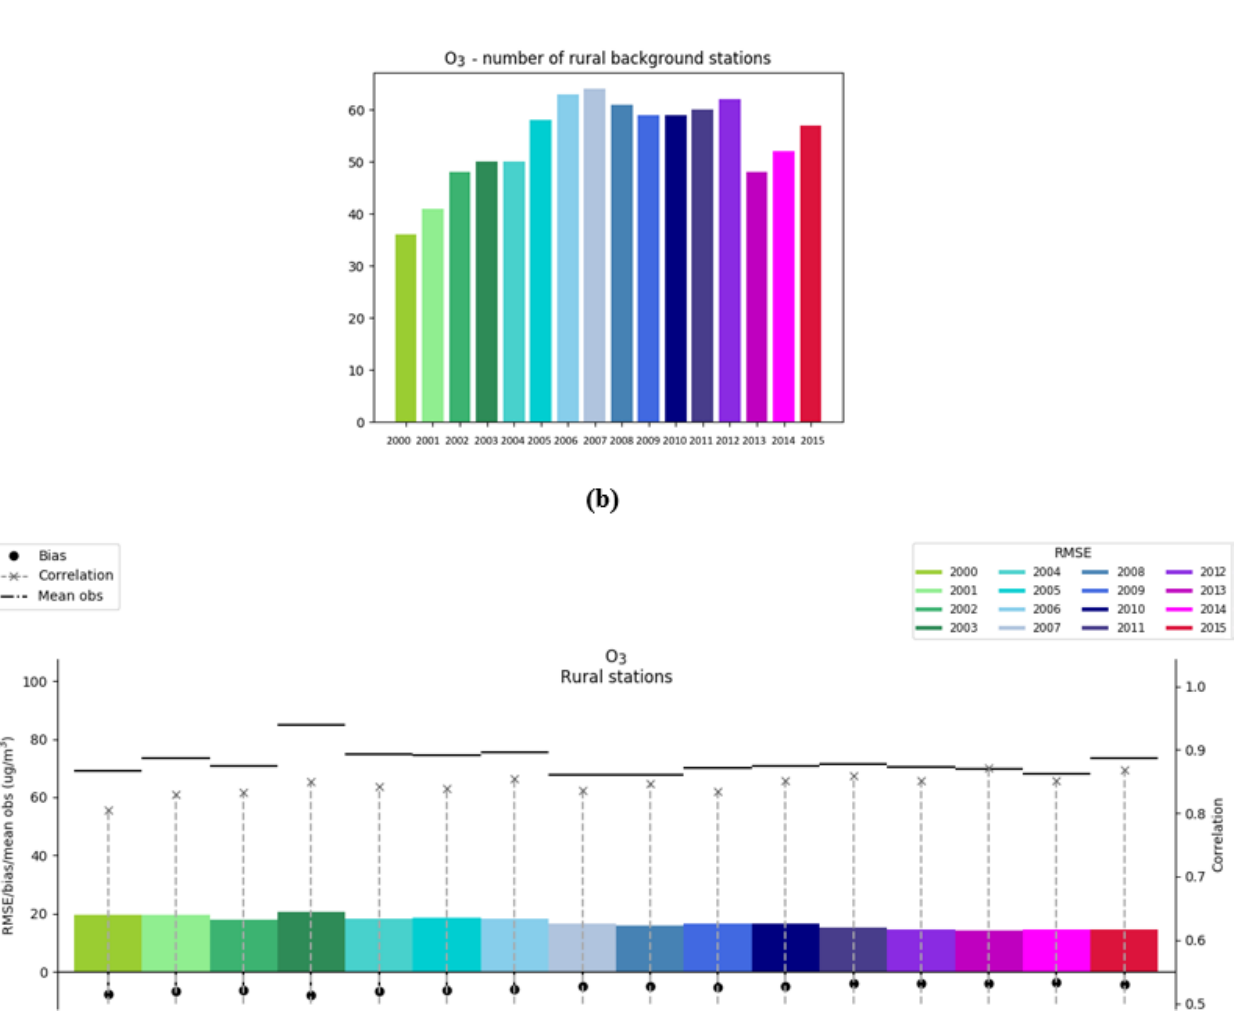
Figure 5. O 3 : statistical indicators calculated using cross-validation technique on daily mean O 3 values measured and estimated over ru- ral background stations for the years 2000 to 2015. (a) Number of rural stations for each year. (b) Bias (black circles), RMSE (colored rectangles), correlation (grey crosses and the associated dashed lines) and mean observation (horizontal